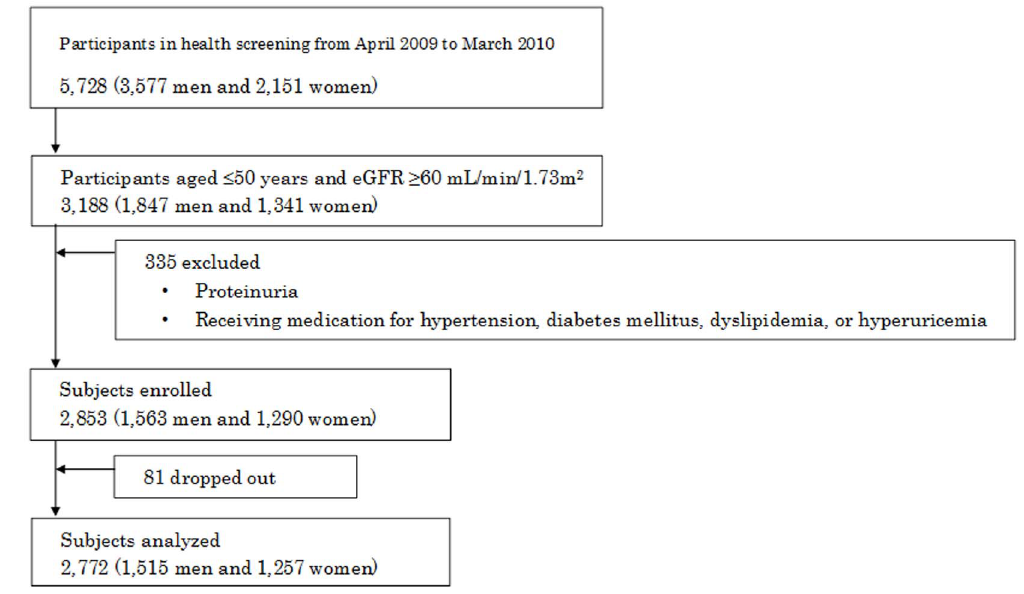
Figure 1. Disposition of the study population.